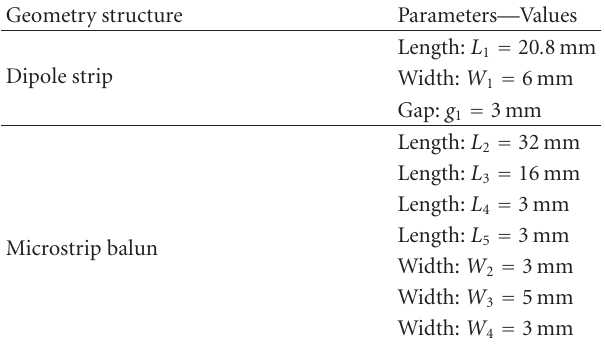
Figure 3: Uniform linear Antenna Array.